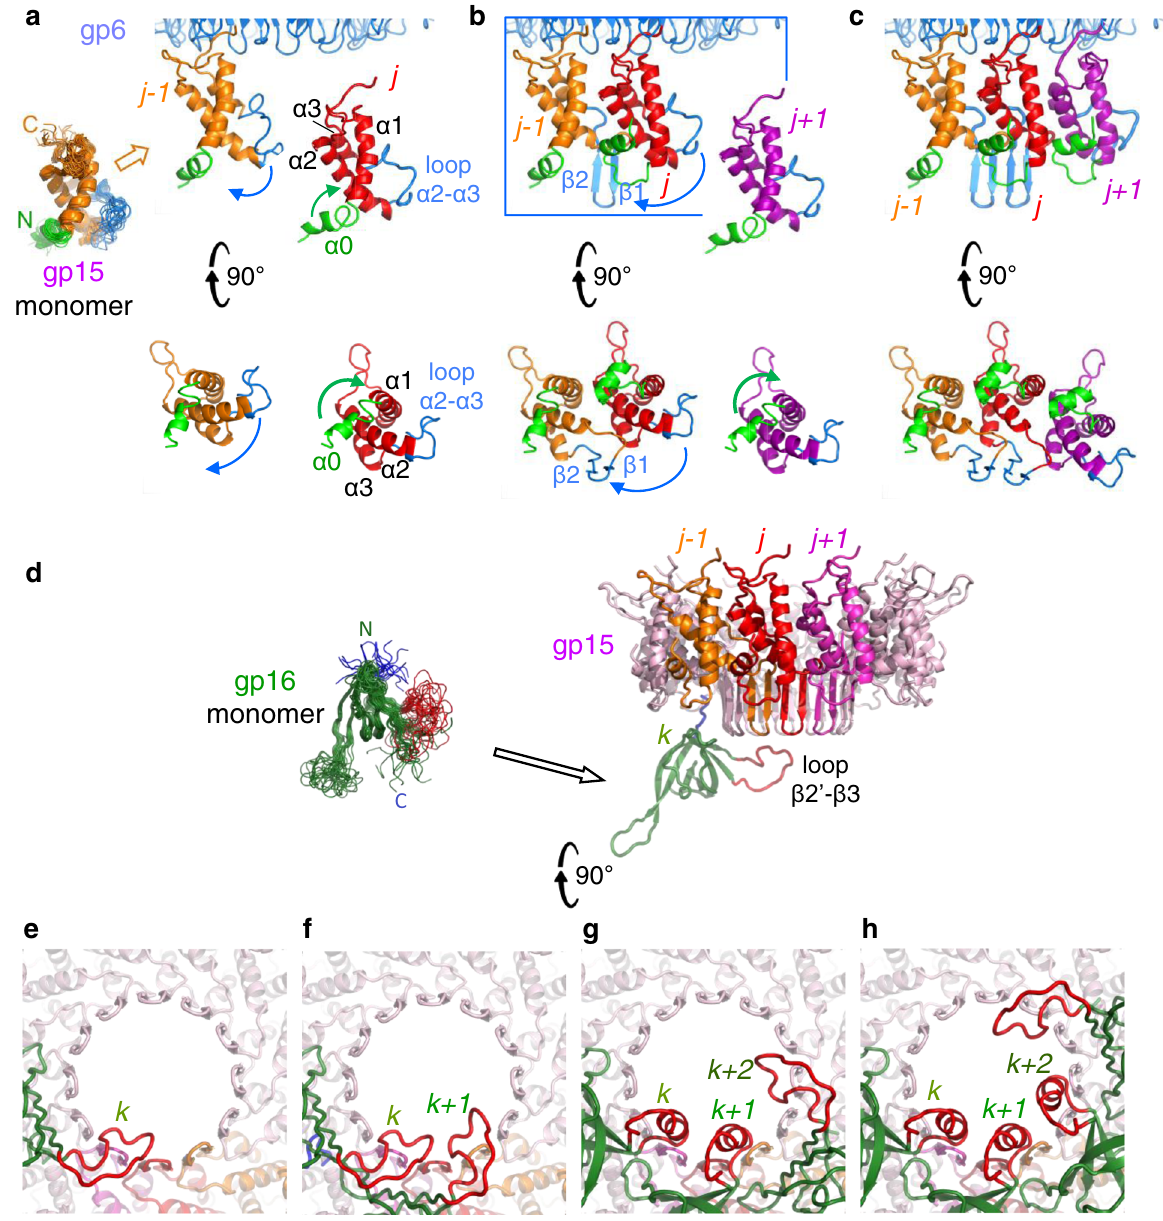
Fig. 5 | Model of connector assembly. a Anchoring of the gp15 monomer in the gp6clip.Twentymodelsofthegp15monomerNMRstructures 19 aresuperposedto highlight stable and fl exible structural elements before assembly (left panel). The N-terminus α 0 and loop α 2- α 3 (shown in green and blue, respectively) undergo conformational changes during assembly. a – c Binding to gp6 of adjacent gp15 subunits leads to clashes between gp15 loops α 2- α 3 inducing changes and folding ofthe β 1- β 2 hairpin(bent blue arrow in a indicatesthe changeoccurring in b upon oligomerization), building the gp15 intersubunit β -barrel. Helices α 0 reposition during oligomerization (bent green arrow in a shows the change